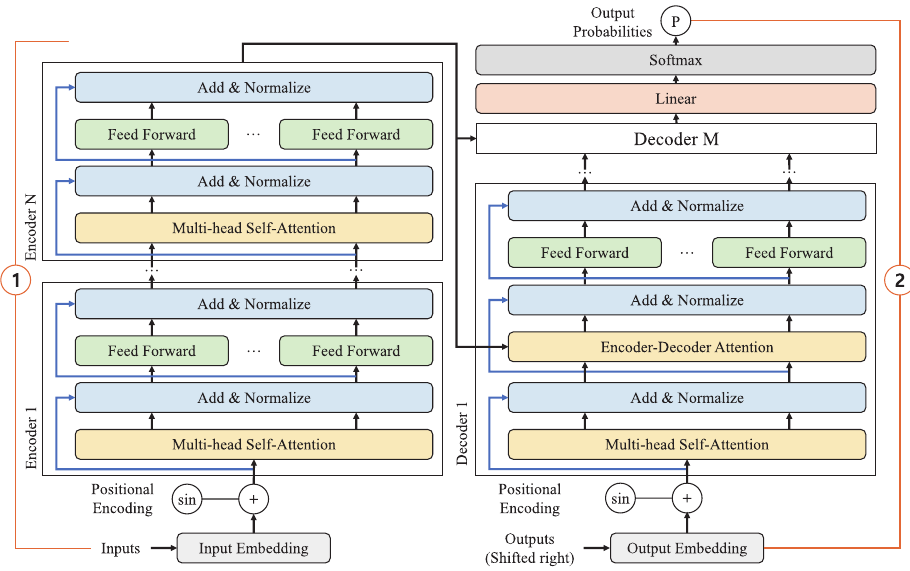
Figure 1. Architecture of text-to-text transfer